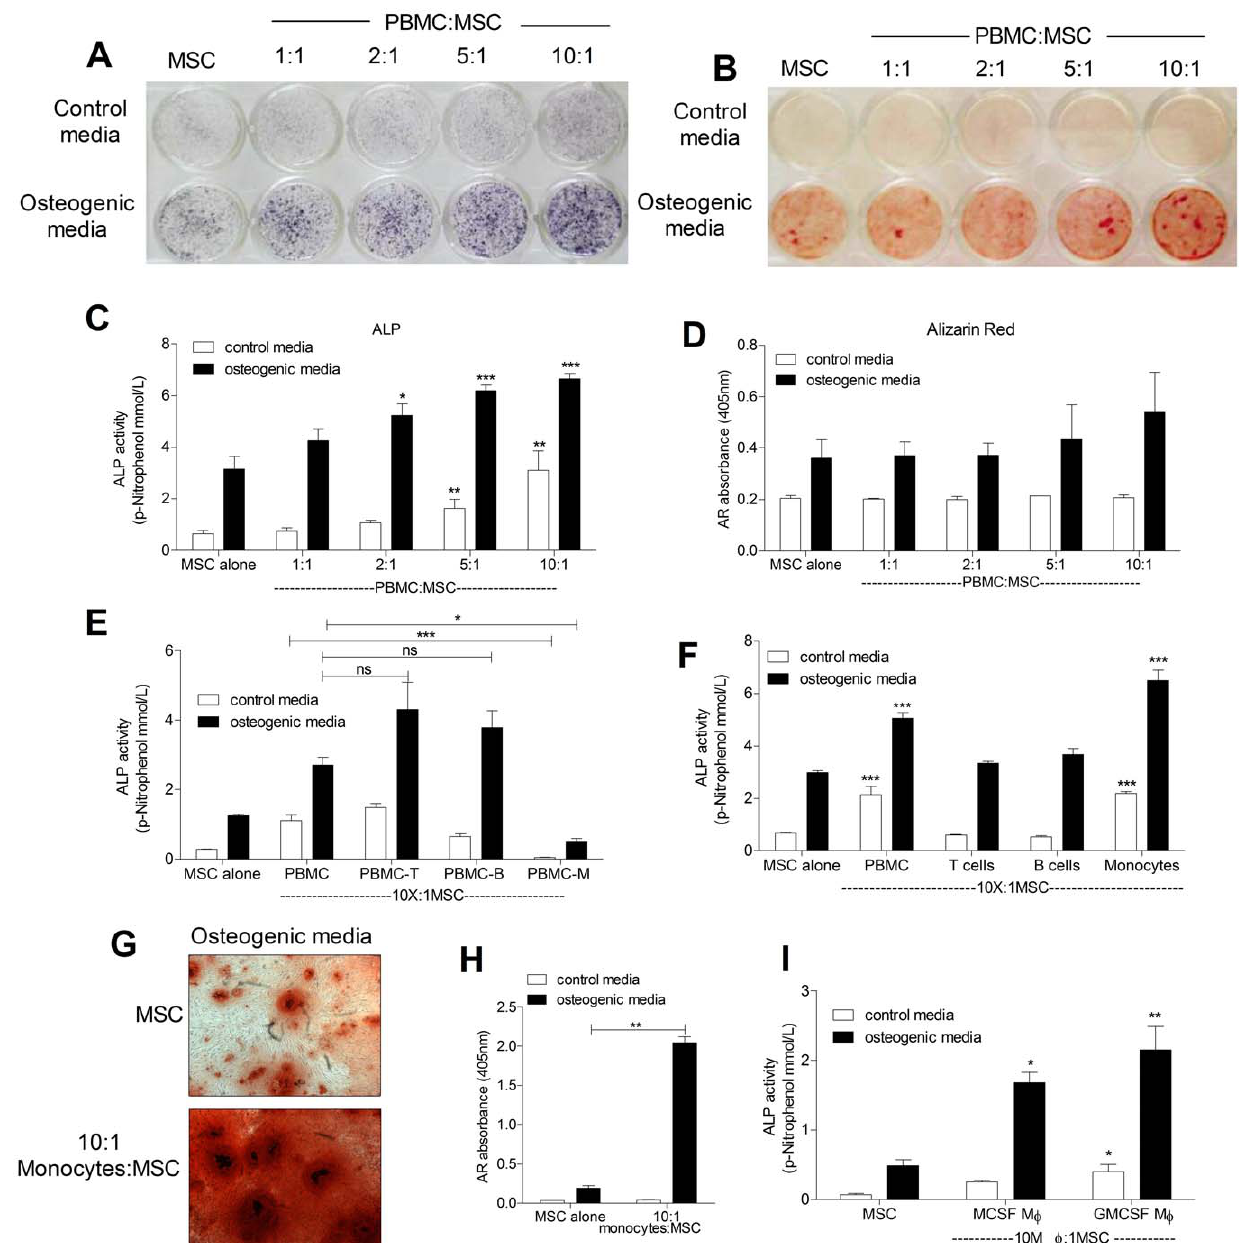
Figure 1. Monocytes potently induce osteogenic differentiation of MSCs. 1 6 10 4 MSCs were cultured either alone or with increasing numbers of PBMCs (1,2,5 or 10 6 10 5 PBMCs), in the presence or absence of osteogenic stimuli. After 7 days, MSC ALP was assessed by staining (A) and after 21 days, bone nodule formation was visualised by Alizarin Red S staining (B). ALP activity (C) and Alizarin Red content (D) were also quantified. Populations of T cells, B cells or monocytes within PBMCs were either depleted (E) or enriched (F) prior to culture with MSC (at 10:1 ratio) and ALP activity was quantified after 7 days. Co-cultures of MSCs with enriched monocyte populations were also kept for 21 days in osteogenic media when bone nodule formation was assessed using Alizarin Red S staining (G) and quantification of dye content (H). Monocytes were differentiated to macrophages (M w ) in either M-CSF or GM-CSF for 5 days prior to co-culture with MSCs at a ratio of 10:1. After 7 days of co-culture, ALP activity was quantified (I). Phase contrast pictures (10X) are representative of three independent experiments performed. Graphs show means 6 SEM of three independent experiments performed in triplicates. *p # 0.05, **p # 0.01, ***p # 0.001. doi:10.1371/journal.pone.0039871.g001 derived factors led to the activation of various signaling pathways also failed to activate any of these signaling pathways (Figure 2E). as shown by I k B a degradation, increased phosphorylation of the Conversely, fixing the MSCs prior to co-culture with monocytes MAPKs; p-38, ERK and JNK, and STAT3 within 30 minutes did not inhibit signaling in response to the supernatants showing (Figure 2E). Supernatants from co-cultures of MSCs and fixed that contact with the cell surface of MSCs is sufficient to induce monocytes that failed to induce MSC differentiation (Figure 2D) the production of monocyte-derived factors necessary for cell